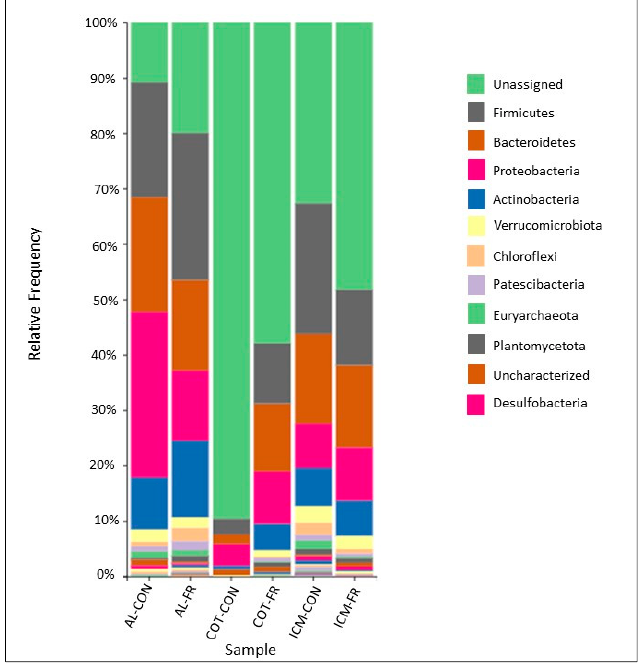
Figure 1. Qualitative phyla-level taxonomy plot of the placental microbiome by feeding treatment. The most relatively abundant taxa across all treatments and tissue types were the unassigned phyla, Firmicutes , Bacteroidetes , Proteobacteria , and Actinobacteria . Tissues include AL = allantois; ICM = intercotyledonary membrane of the chorion; COT = cotyledon. Treatments include CON = control diet; FR = 70% feed intake restricted diet.